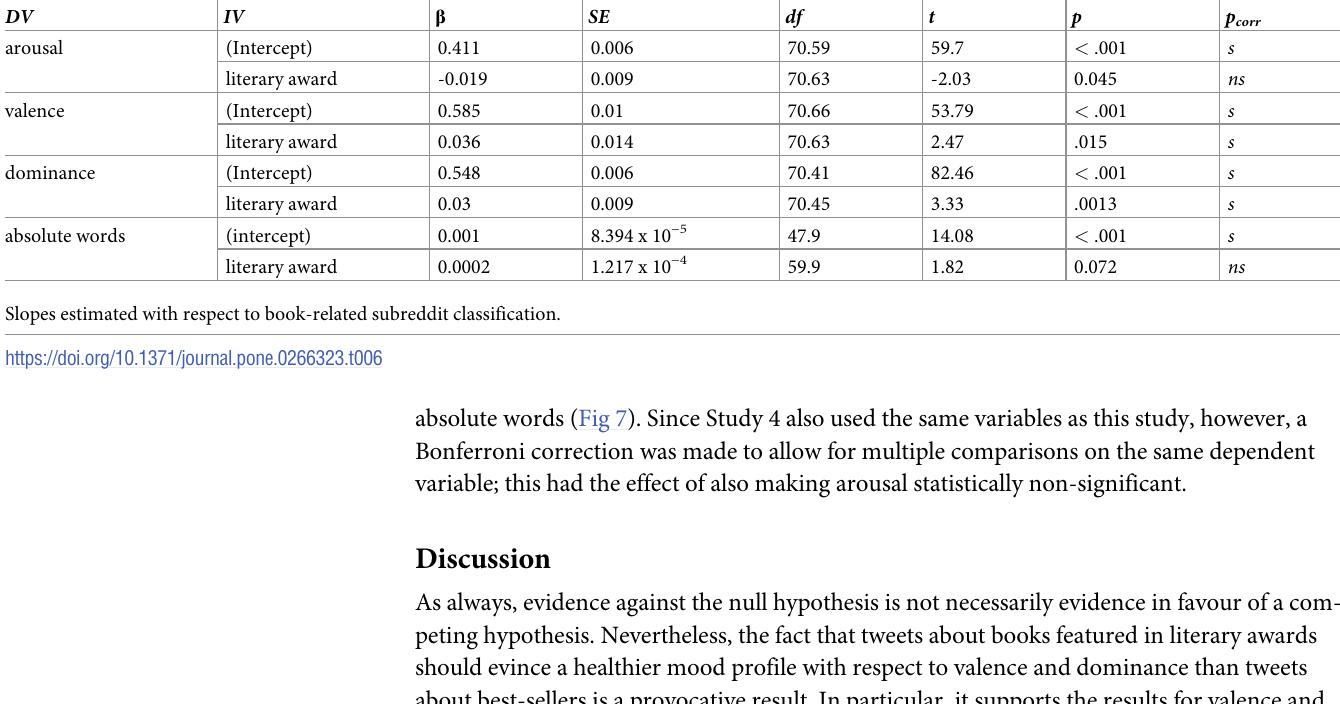
Table 6. Results of mixed linear models for absolute words, valence, arousal, and dominance regressed on category (best-seller vs literary award) for Study 5. DV